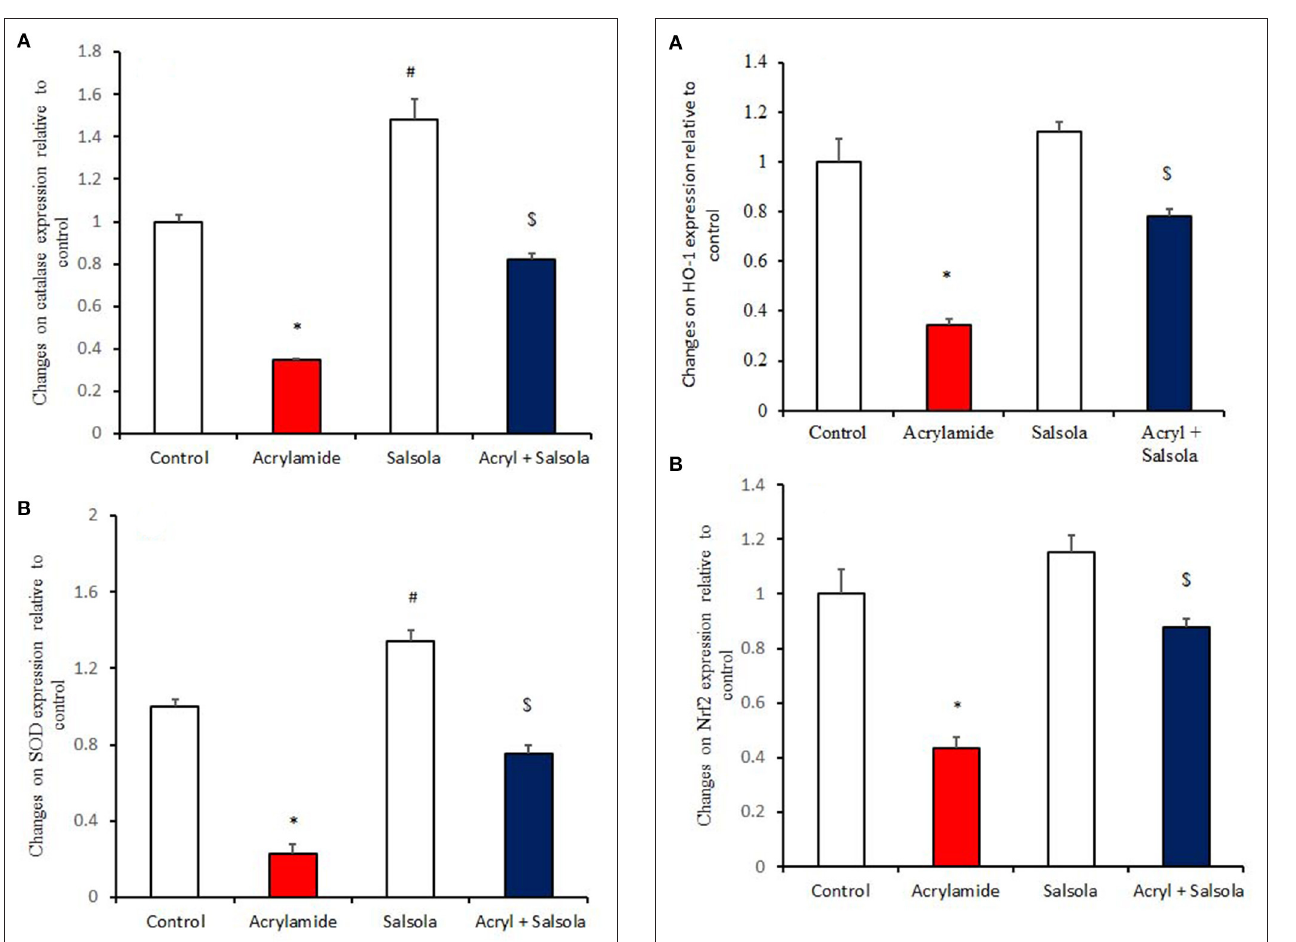
FIGURE 4 | The ameliorative impact of Salsola imbricata extract on the mRNA expression of HO-1 and Nrf2 in acrylamide-administered rats ( n = 10). Graphic presentation of hepatic expression by qRT-PCR analysis of HO-1 and Nrf2 in different groups of rats after normalization with the housekeeping gene